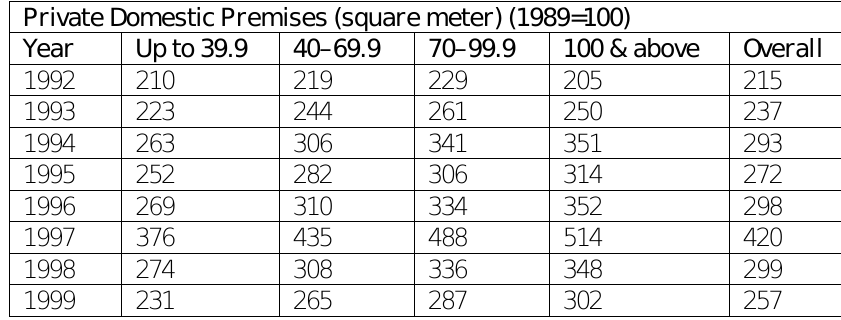
Table 4: Property price indices for private domestic premises Private Domestic Premises (square meter)